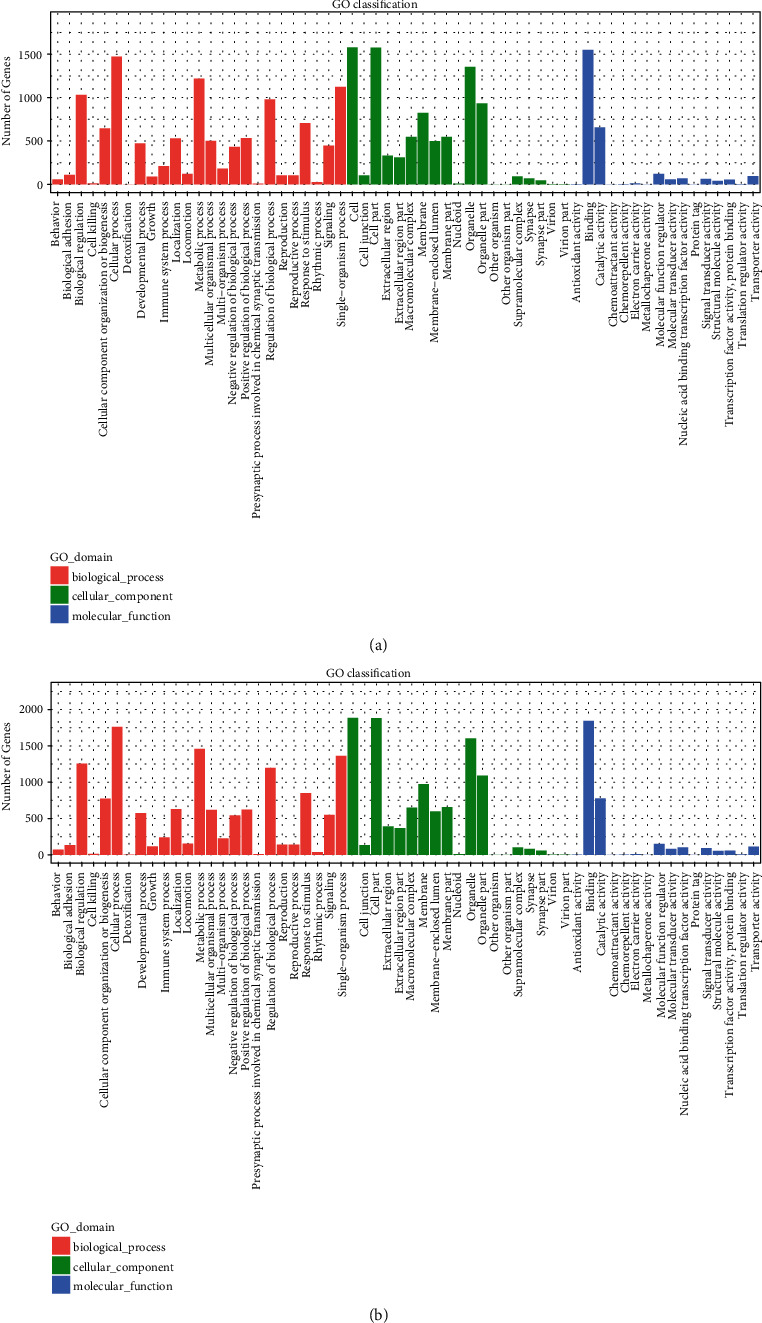
GO functional classification statistics of differentially expressed lncRNA target mRNAs. (a). shRNA-ANXA7 vs. control-shRNA. (b). shRNA-JNK vs. control-shRNA.